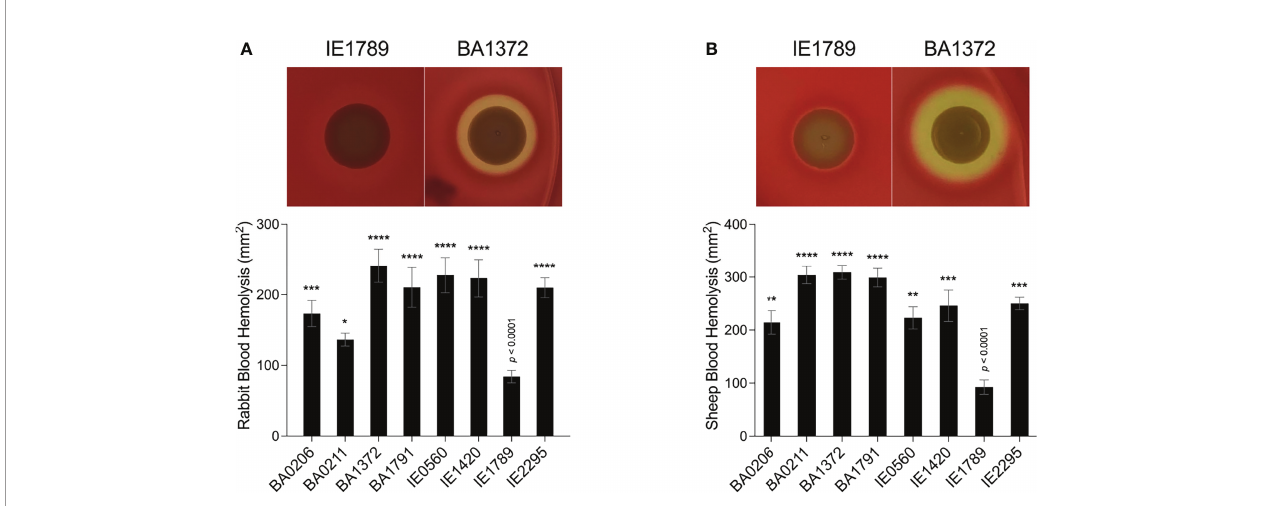
FIGURE 4 | Hemolytic activity in S. aureus CC5 isolates. Overnight cultures of S. aureus CC5 isolates were washed and spotted onto (A) 5% rabbit blood and (B) 5% sheep blood TSA II agar plates. Zones of hemolysis were measured after overnight growth. (Top) Representative images of hemolytic activity in strains IE1789 and BA1372. (Bottom) Relative levels of hemolysin production as measured in an erythrocyte lysis assay. Data are represented as mean ± SEM. *, p < 0.05, **, p < 0.005, ***, p < 0.0005, ****, p < 0.0001, one-way ANOVA with Holm-S ̌ ı ́ da ́ k ’ s multiple comparisons test to the non-hemolytic strain